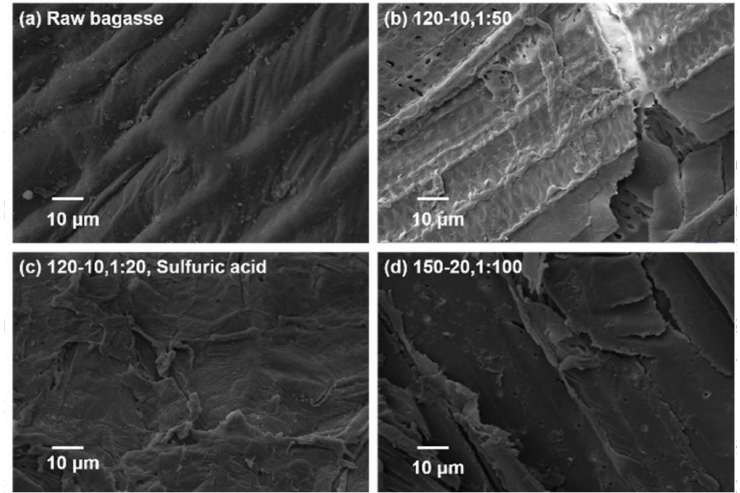
Figure 5. SEM of untreated and pretreated bagasse (120–10, 1:50 means temperature–time, solid–liquid